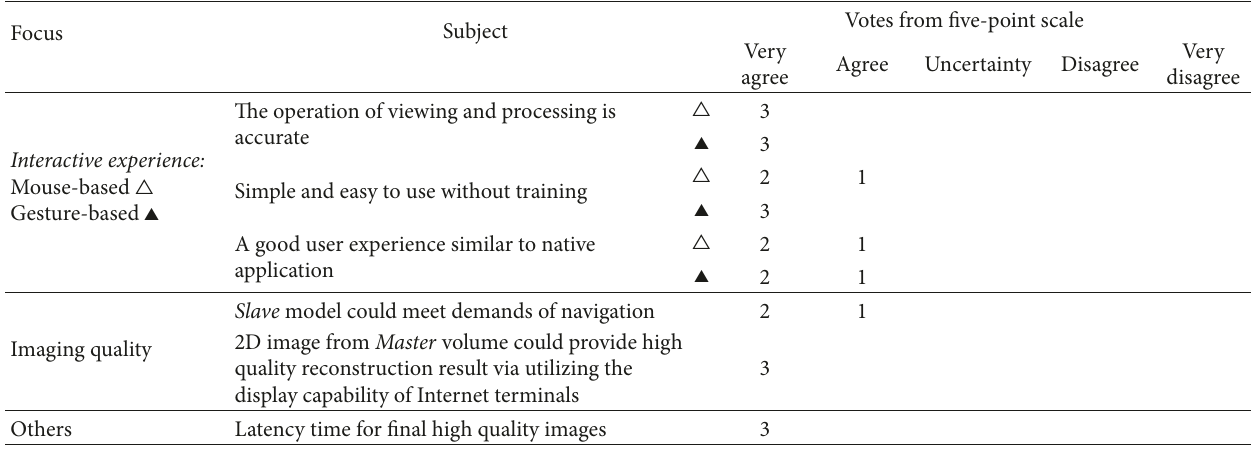
Table 2: Statistic results of the five-point scale concerning the interactive experience and imaging quality. Focus